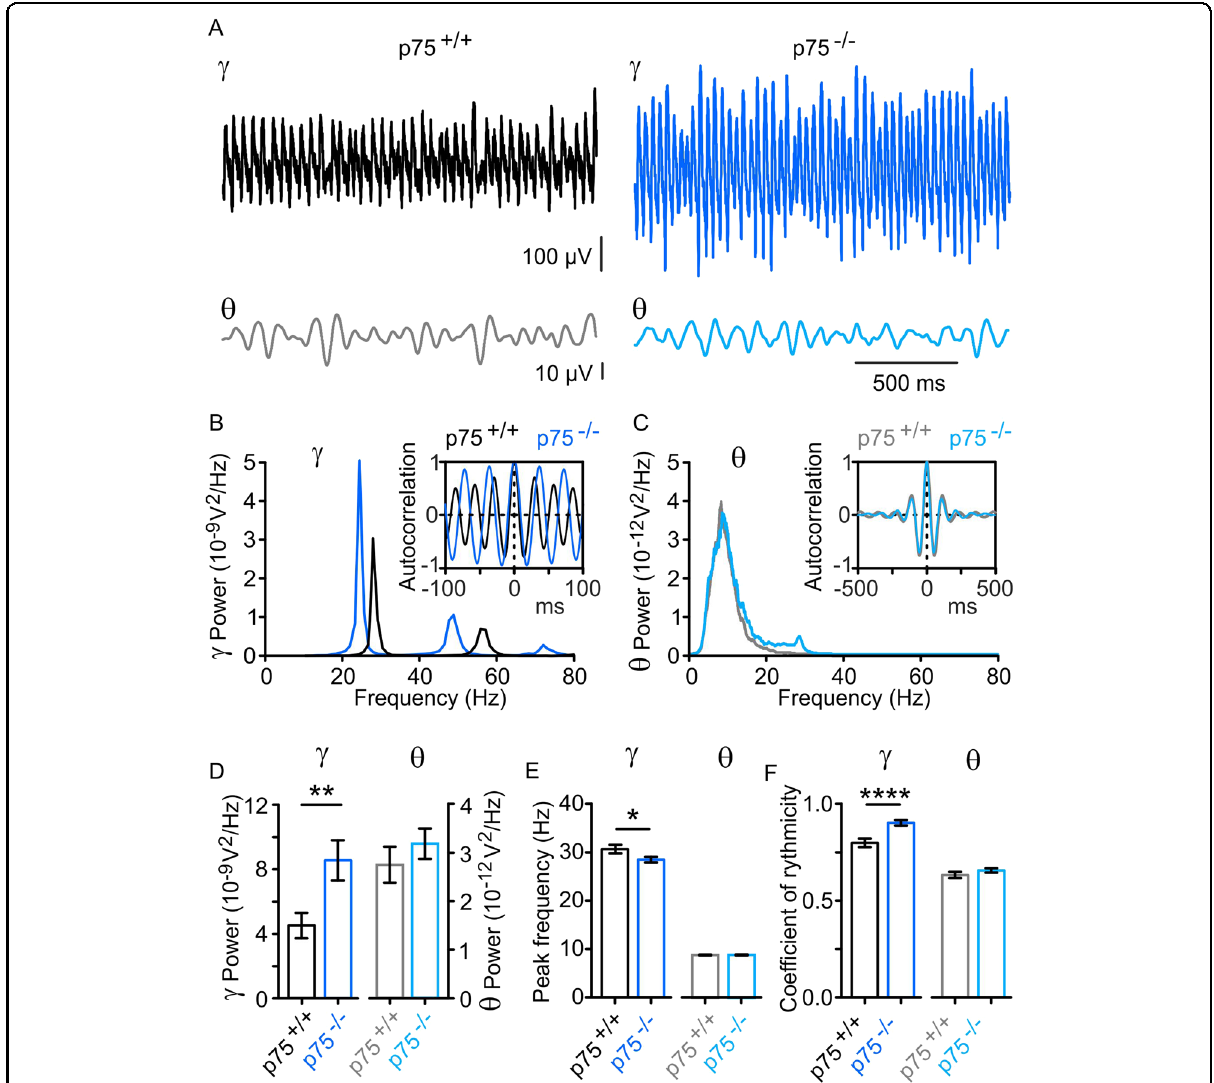
Fig. 1 p75 NTR ablation induces alterations of spectral features and rhythmicity of gamma oscillations, while theta parameters remain unaltered. A Representative sample traces of CCh-induced gamma oscillations ( γ , top traces) and the 4 – 10 Hz fi ltered theta component ( θ , bottom traces) in hippocampal slices from p75 + / + (black) and p75 − / − (blue) mice, respectively, 20 min after CCh bath application. B , C Power spectra of γ and θ oscillations recorded in the experimental conditions described in ( A ). Insets: Corresponding γ and θ oscillation autocorrelograms showing a signi fi cant increase of the lag to peak measured on the second peak in p75 − / − mice (p75 − / − mice: 34.7 ± 0.7 ms, n = 3; p75 + / + mice: 31.0 ± 0.7 ms, n = 24, p = 0.0004 Student ’ s t test). D Mean integrated power of γ oscillations (20 – 80 Hz; p75 − / − : 8.6 ± 1.3 × 10 − 9 V 2 , n = 31; p75 + / + : 4.5 ± 0.78 × 10 − 9 V 2 , n = 24, p = 0.0067) and θ (4 – 10 Hz; p75 + / + : 2.7 ± 0.37 × 10 − 12 V 2 , n = 24; p75 − / − : 3.2 ± 0.31 × 10 − 12 V 2 , n = 31, p = 0.1856) from experiments described in ( A ), showing a signi fi cant increase in the 20 – 80 Hz frequency band in p75 − / − mice (blue), while θ spectrum remains unaltered. E Peak frequency of γ and θ spectra. Γ oscillations from p75 − / − mice appear to be slower than those recorded in p75 + / + mice (p75 + / + : 30.9 ± 0.9 Hz, n = 24 vs. p75 − / − : 28.7 ± 0.6 Hz, n = 31, p = 0.0175). Peak frequency of θ spectra remains similar in both mice strains (p75 + / + : 8.9 ± 0.1 Hz, n = 24; p75 − / − : 8.9 ± 0.1 Hz, n = 31, p = 0.2596). F Coef fi cient of rhythmicity (Cr) calculated from the autocorrelogram (see “ Methods ” ) of γ oscillations reveals a higher rhythmicity of γ oscillations recorded in p75 − / − mice (p75 + / + : 0.8 ± 0.02, n = 24 vs. p75 − / − : 0.91 ± 0.01, n = 31, p < 0.0001). The quality of θ oscillations (Cr) recorded in p75 + / + and p75 − / − mice remains similar between both strains (p75 + / + : 0.6 ± 0.02, n = 24; p75 − / − : 0.7 ± 0.01, n = 31, p = 0.1370). Data are presented as mean ± SEM. * P < 0.05, ** p < 0.01, and **** p < 0.0001 compared to p75 + / +